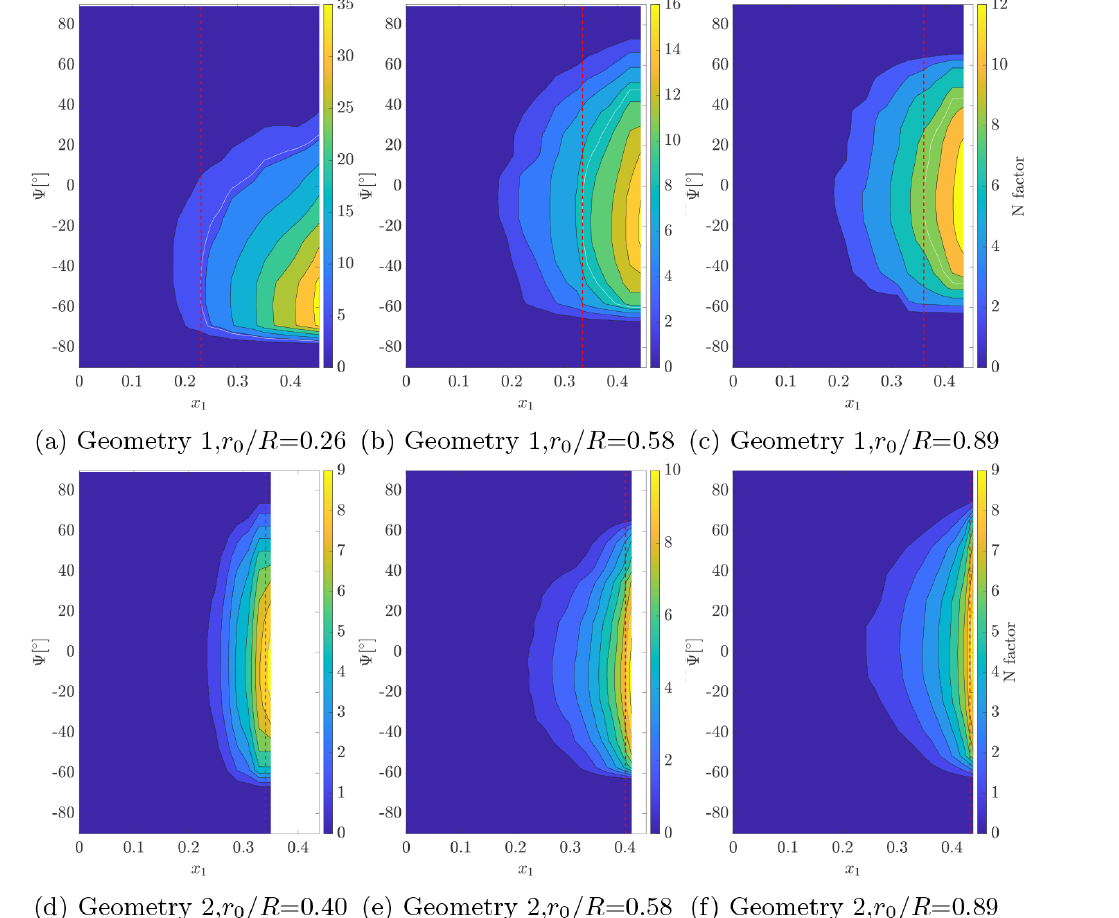
Figure 11. N -factor contours from PSER for three radial positions. The white line indicates the critical region, and the red dashed line shows the transition